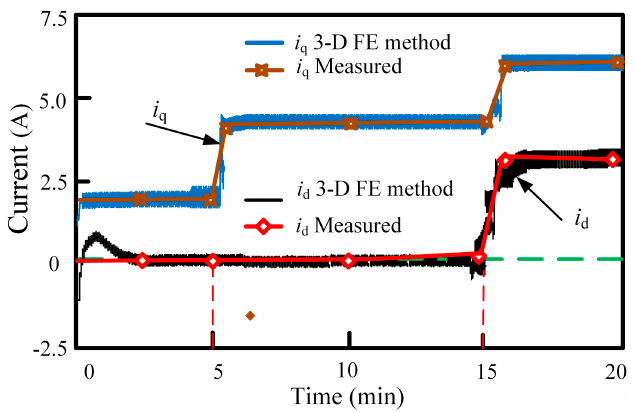
Figure 19. Comparison of the input d , q -axis current curves between simulated and experimental results.